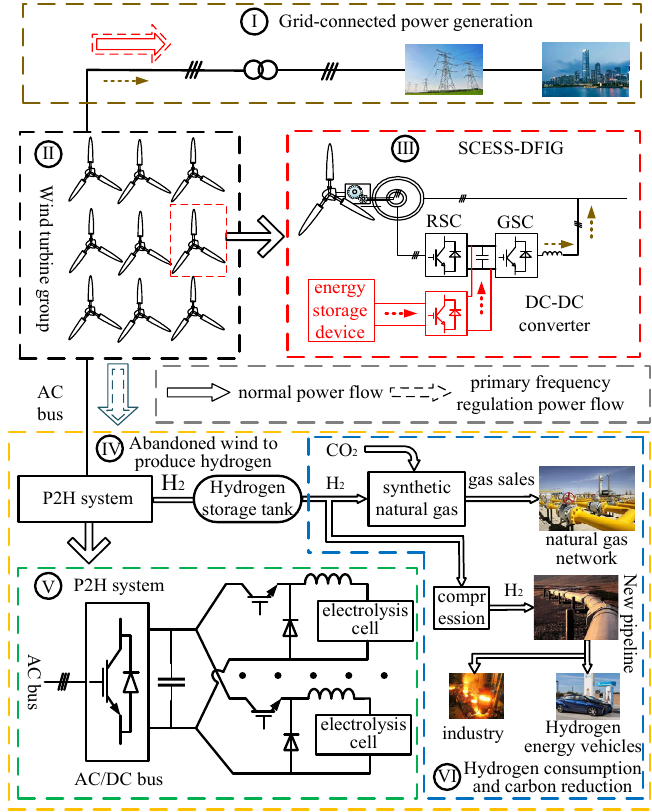
Figure 1. Schematic diagram of system architecture of a SCESS-DFIG-P2H generating station. Among them, the wind turbine group is composed of a plurality of SCESS-DFIGs, In order to make full use of wind energy, the DFIG runs normally in the MPPT state. shown in module III, as the energy source of the whole system. The mechanical power that the P wind obtains the maximum value P MPPT